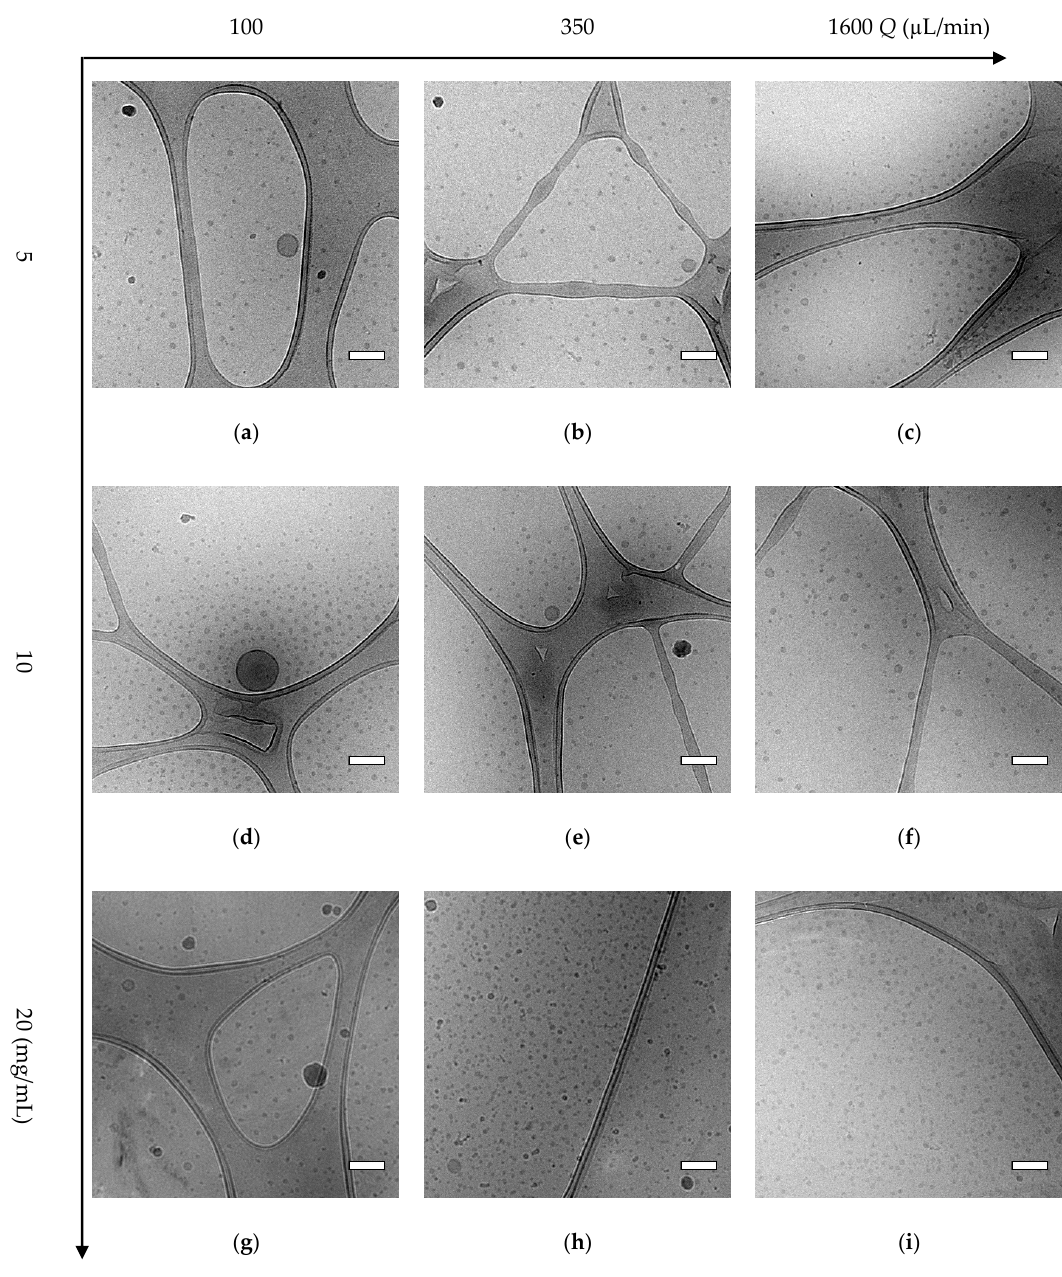
Figure 6. Cryo-TEM pictures of polymer D (mPEG 5K - b -p(HPMA-Bz) 2.7K ) nanoparticles prepared using different polymer concentrations and flow rates. ( a ) 5 mg/mL and 100 µL/min, ( b ) 5 mg/mL and 350 µL/min, ( c ) 5 mg/mL and 1600 µL/min, ( d ) 10 mg/mL and 100 µL/min, ( e ) 10 mg/mL and 350 µL/min, ( f ) 10 mg/mL and 1600 µL/min, ( g ) 20 mg/mL and 100 µL/min, ( h ) 20 mg/mL and 350 µL/min, ( i ) 20 mg/mL and 1600 µL/min. Scale bars indicate 50 nm.